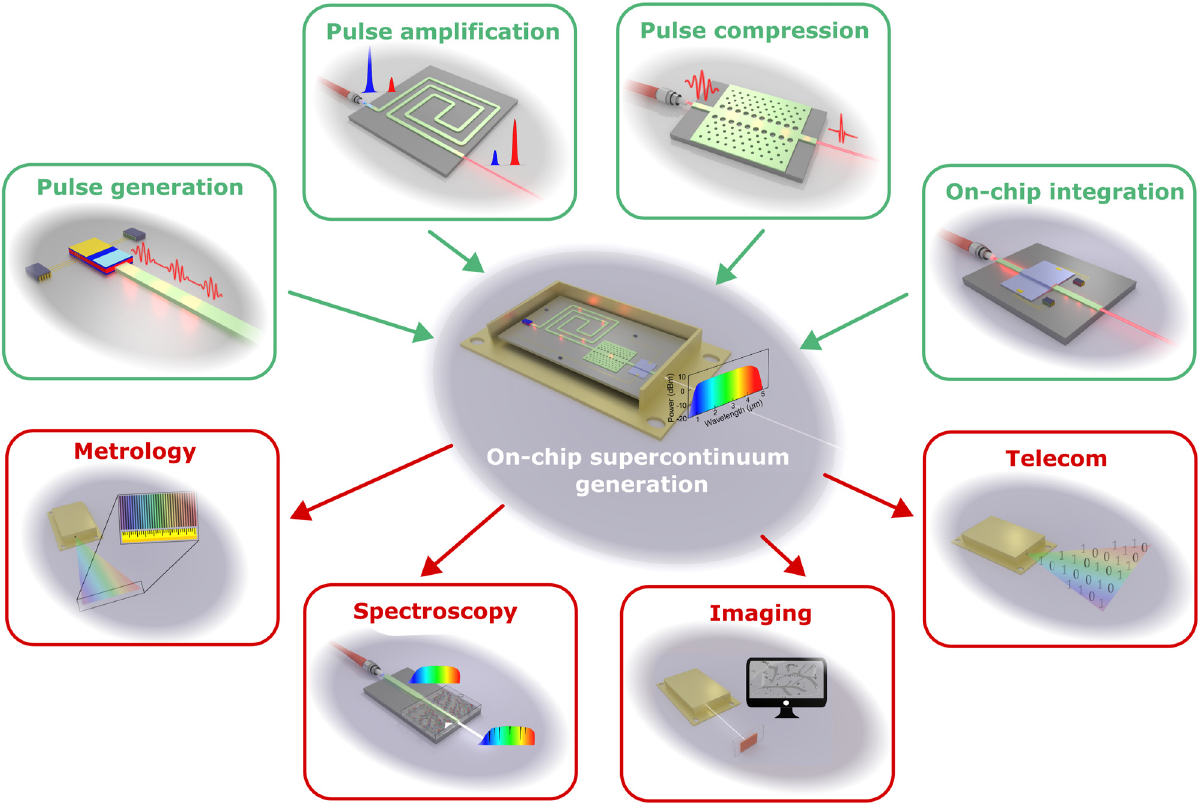
Figure 1: Necessary building blocks (top, green frames) for full integration of SC sources (center) and potential applications (bottom, red